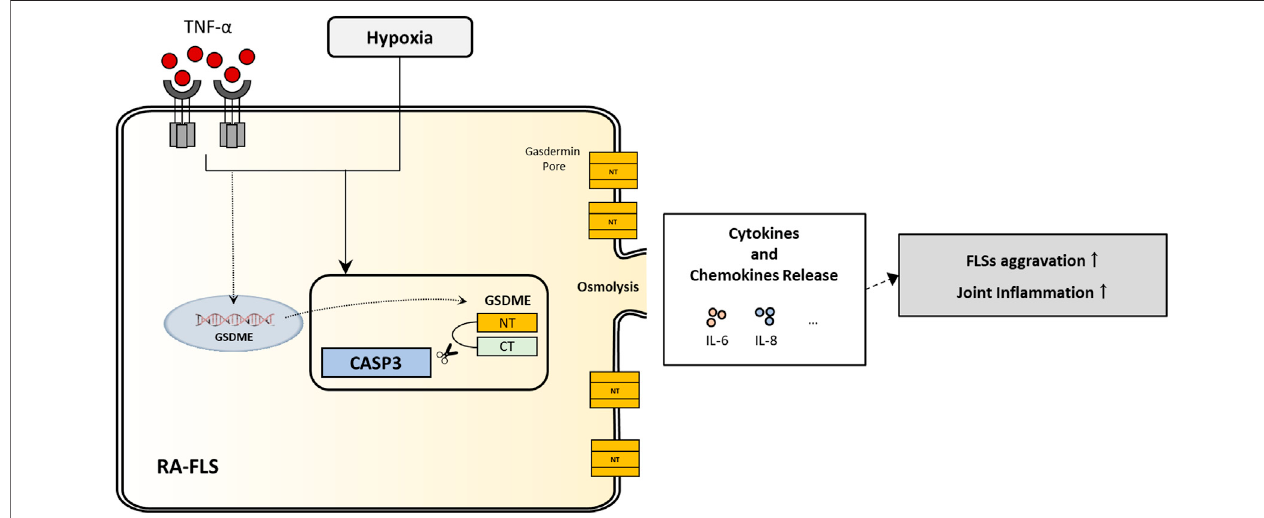
FIGURE 6 | Illustration of a novel regulation of in fl ammatory cytokines secretion and aggressive cell behaviors in RA-FLSs through GSDME-mediated pyroptosis.